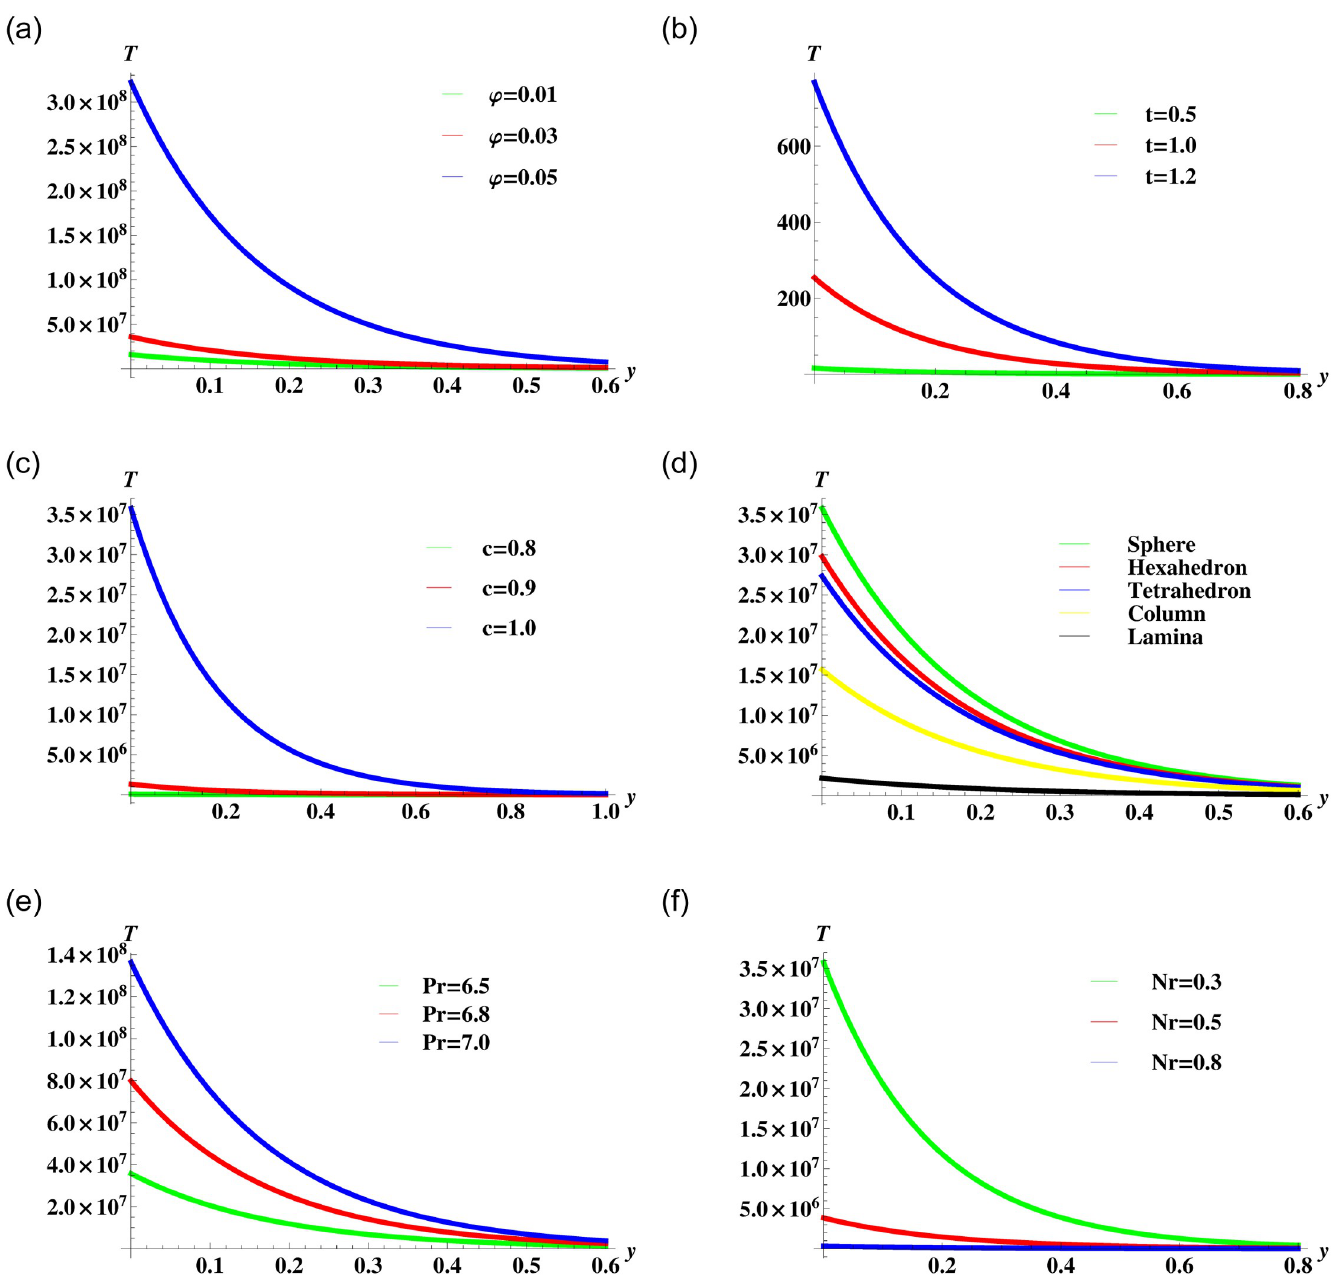
Fig 10. Temperature profile (69) for various values of φ , t , c , P and κ f = 0.613 are